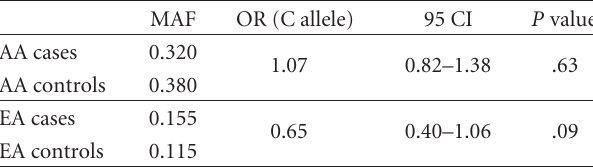
Table 3: Case-control association of rs3813065 with SLE in African- and European-American subjects.